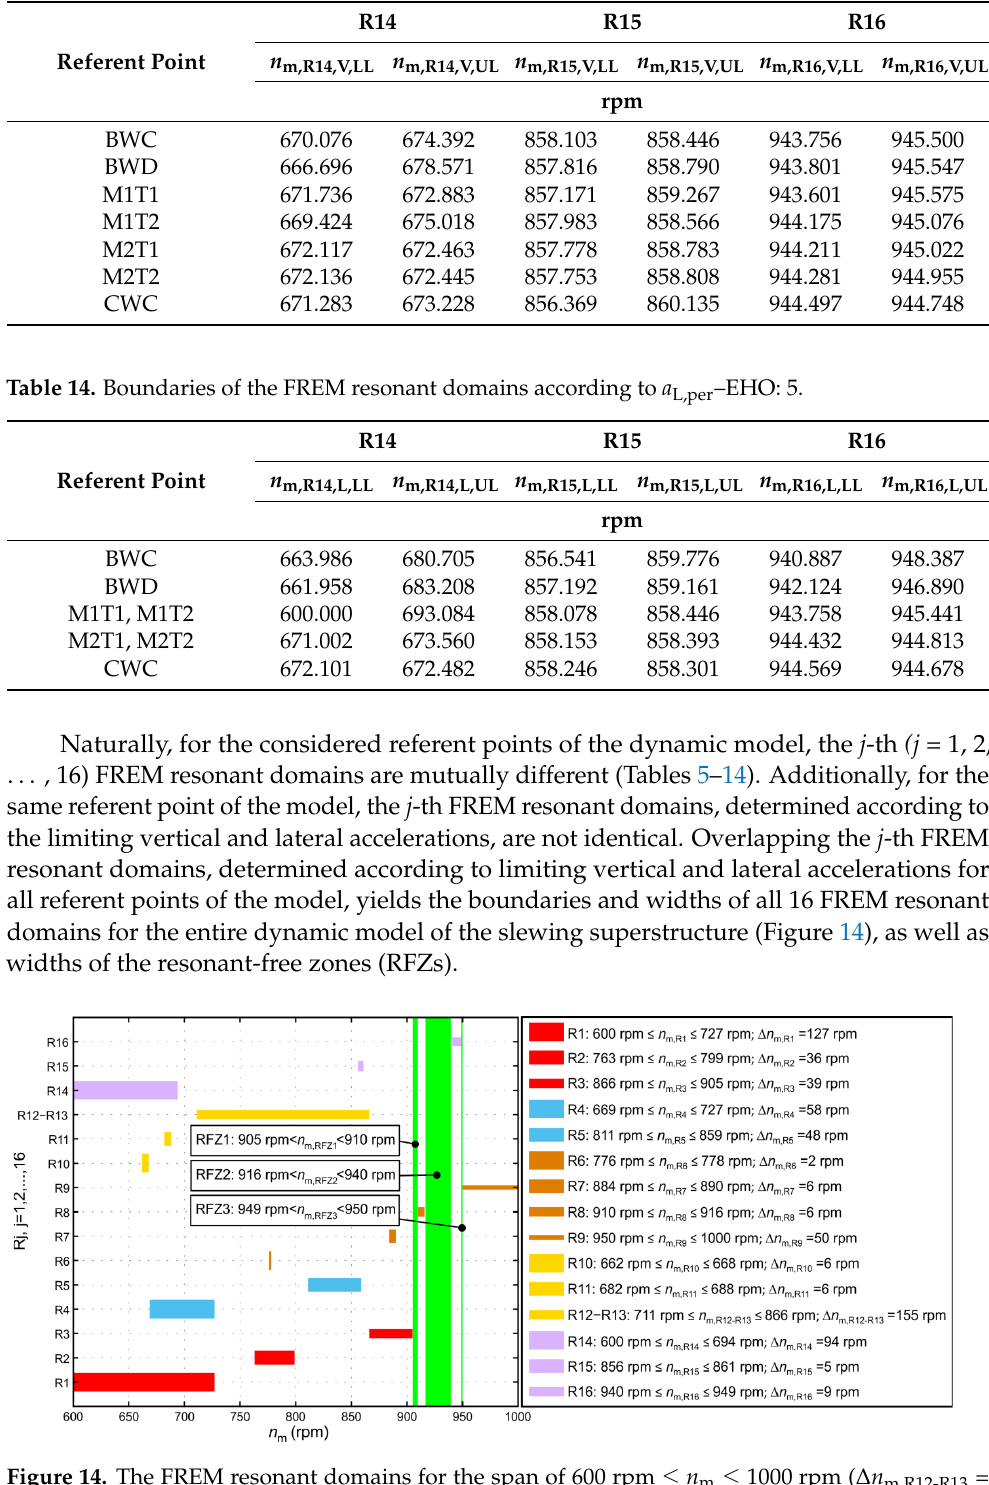
Figure 14. The FREM resonant domains for the span of 600 rpm ≤ n m ≤ 1000 rpm ( ∆ n m,R12-R13 = n m,R13,UL – n m,R12,LL